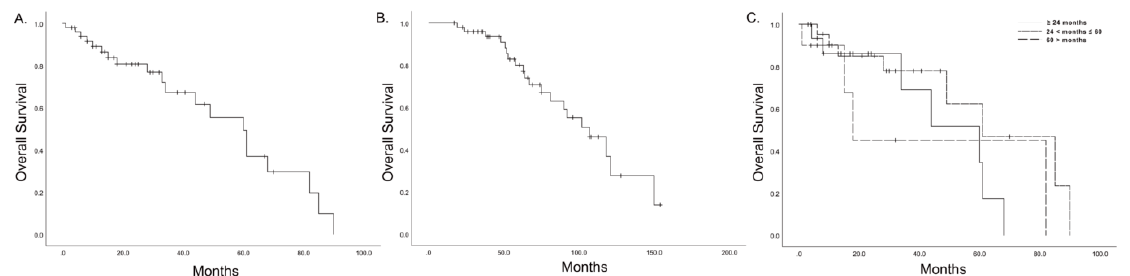
Figure 2. ( A ) Overall survival after repeated pancreatectomy. ( B ) Overall survival calculated from the time of the initial pancreatectomy. ( C ) Overall survival according to the time interval from the initial radical pancreatectomy. Table 3. Univariate analysis of the predictors of overall survival after repeated pancreatectomy. Variables